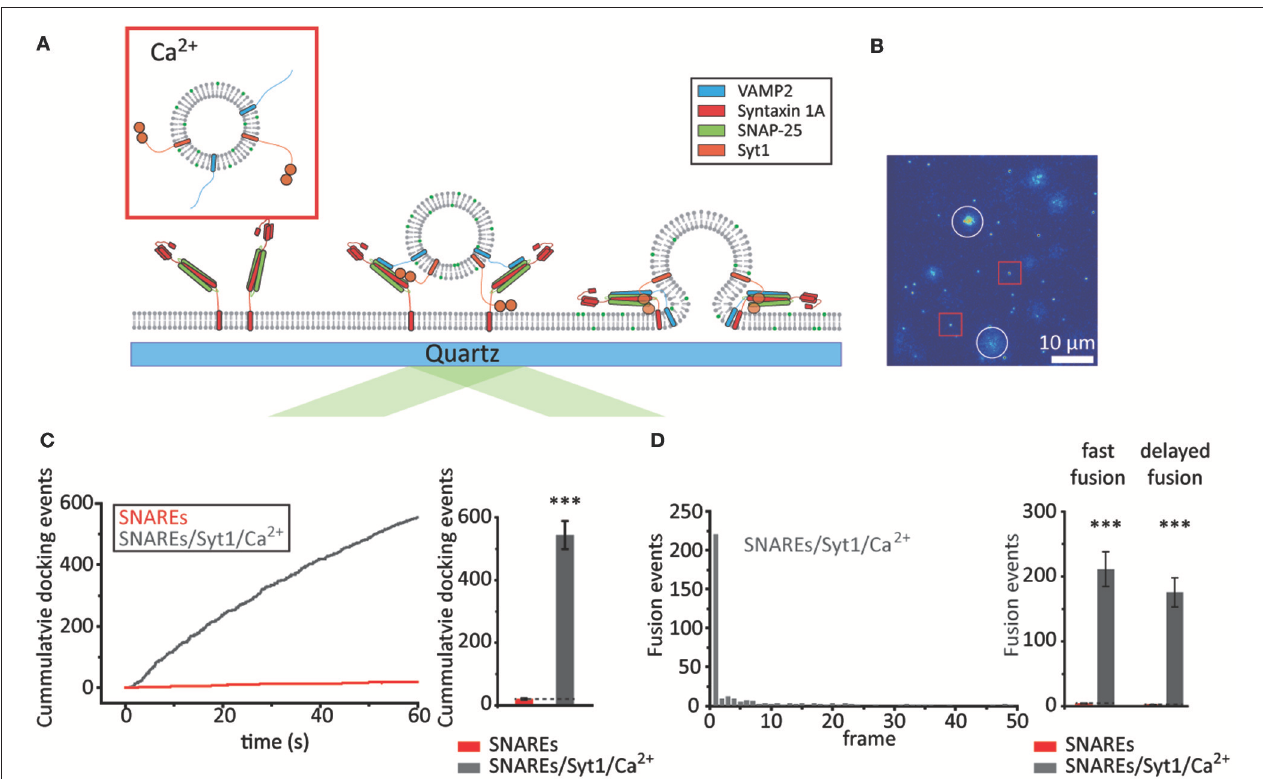
FIGURE 2 | Syt1 increases the probability of fast membrane fusion in the presence of Ca 2 + . (A) Schematics for the single vesicle-to-SBL fusion assay with Syt1 and Ca 2 + . (B) Screen shot (55 × 55 µ m) of the video recording. The red box and white circles indicate representative docked and fusing vesicles, respectively. (C) Docking events with v-vesicles reconstituted with both VAMP2 and Syt1 in the presence of 500 µ M Ca 2 + (gray) compared to v-vesicles reconstituted with VAMP2 only (red, also shown in Figure 1E ). Representative time trace of cumulative counts of cumulative counts of docking events against time (left) and the number of docked vesicles during the 1min observation period (right, total of 1,633 docking events from three independent recordings). (D) A representative histogram of docking-to-fusion delay distribution from a single 1min recording (left, each frame is 20ms). The number of fast and delayed fusion events within a 1min recording (right). A total of 23 and 1,161 fusion events were observed for SNAREs (red, also shown in Figure 1F ) and SNAREs/Syt1/Ca 2 + (gray), respectively. For (C) and (D) the data are shown as means ± SD . Statistical significance was assessed by Student’s t -test (*** p < 0.005; NS, no significant difference; n = 3 independent